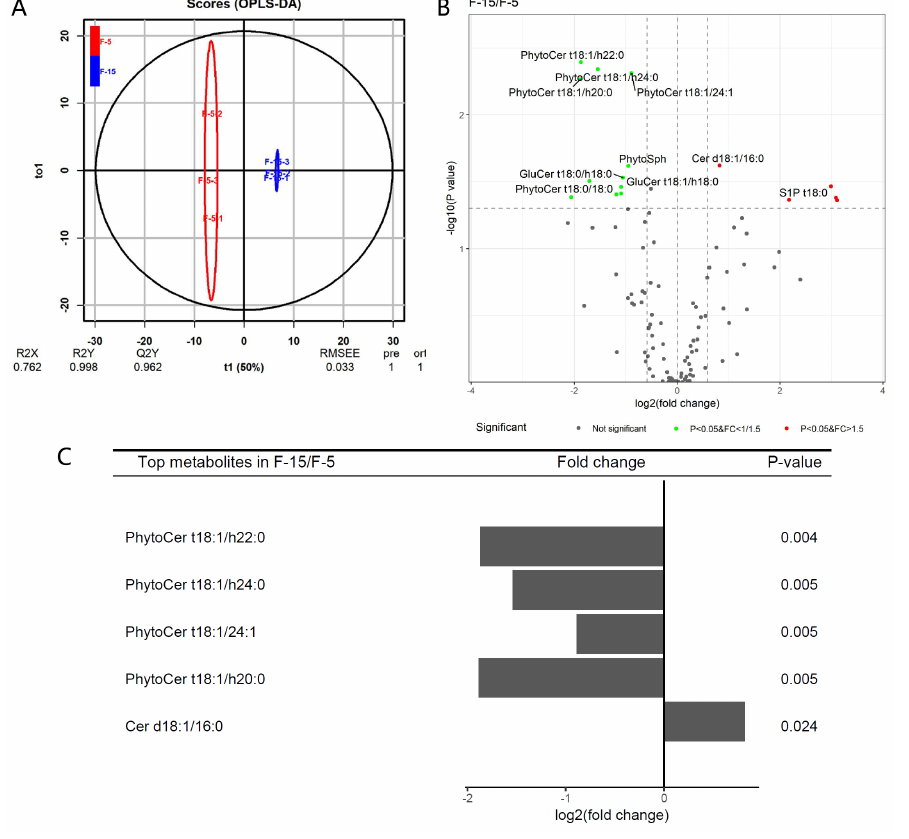
Figure 5. Different sphingolipid molecular species in fiber cells between 5 DPA and 15 DPA. ( A ) OPLS- DA score plot between the 5 DPA group and the 15 DPA group. ( B ) Volcano map of sphingolipid molecular species in fiber cells between 5 DPA and 15 DPA. ( C ) The fold changes of the top five sphingolipid molecular species that significantly changed between 5 DPA and 15 DPA. Cer, ceramides; PhytoCer, phytoceramides; S1P, sphingosine-1-phosphate; PhytoSph, phytosphingosines; GluCer, glucosylceramides. “d18:1” indicates that the long-chain bases (LCB) of sphingolipids had t2 hydroxyl groups (d), 18 carbon atoms, and 1 double bond; “t18:1” indicates that the LCB had 3 hydroxyl groups (t), 18 carbon atoms, and 1 double bond; “16-26:0/1” indicates that the long-chain fatty acid (LCFA) of sphingolipids had 16 to 26 carbon atoms and no or 1 double bond; and “h16-26:0” indicates that the long-chain fatty acids (LCFA) of sphingolipids were hydroxylated fatty acyls (h) and had 16 to 26 carbon atoms and no double